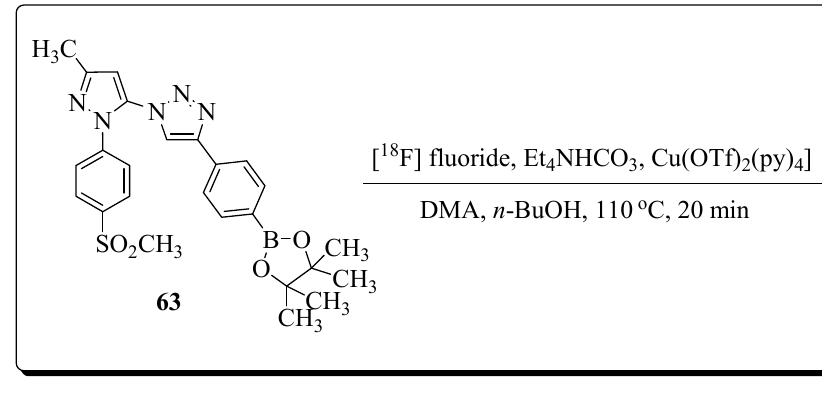
Figure 20. Synthesis of [ 18 F]triacoxib.